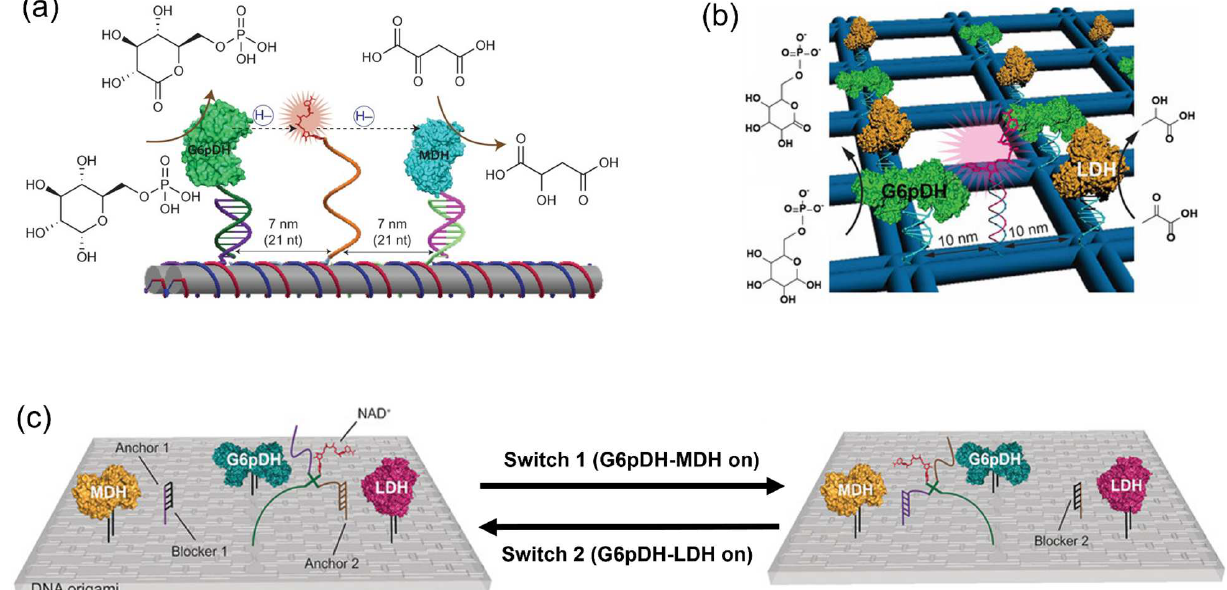
Figure 10. Enzyme cascade reactions on the DNA scaffolds with swinging arm. ( a ) Glucose-6-phosphate dehydrogen- ase/malic dehydrogenase (G6pDH/MDH) assembled on the DNA scaffold with the swinging arm modified with NAD + . The NAD + -modified single-stranded poly(T) 20 is positioned halfway between the two enzymes, facilitating the transfer of hydrides [90]. ( b ) Glucose-6-phosphate dehydrogenase/lactic dehydrogenase (G6pDH/LDH) assembled on the DNA scaf- fold with the swinging arm modified with NAD + . The double-stranded DNA swinging arm carrying an NAD + cofactor at the tip was positioned halfway between each pair of G6pDH and LDH to transfer the hydride intermediate [91]. ( c ) G6pDH, MDH and LDH co-assembled on the DNA scaffold with a NAD + -anchored Holliday junction. In the presence of switch 1, the NAD + substrate channeling binds to anchor 1 and is located between G6pDH and MDH, thus driving the G6pDH/MDH pathway. In the presence of switch 2, the substrate channeling is located between G6pDH and LDH, driving the G6pDH/LDH pathway [92]. Reprinted with permission from: ( a ) Ref. [90]. Copyright 2014 Springer Nature; ( b ) Ref.